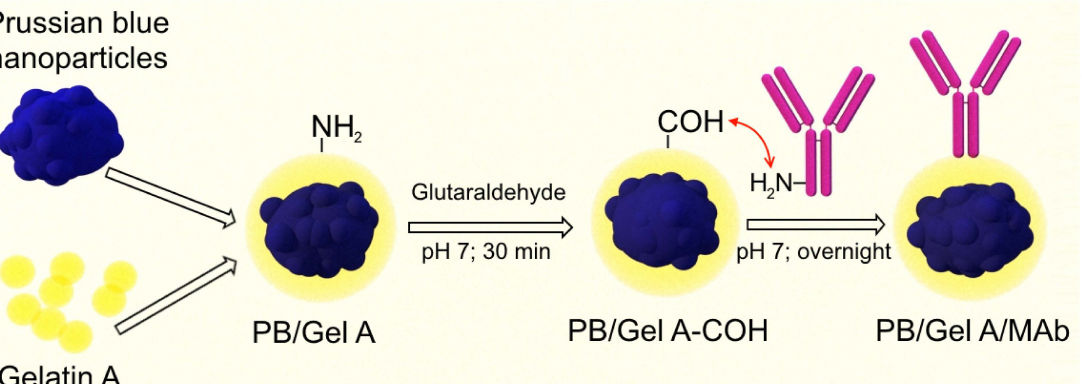
Figure 4. Conjugation of gelatin-coated Prussian blue nanoparticles with monoclonal antibodies. Gelatin amine groups were cross-linked with glutaraldehyde. Then, amine groups of antibodies were reacted with the surface carbonyl